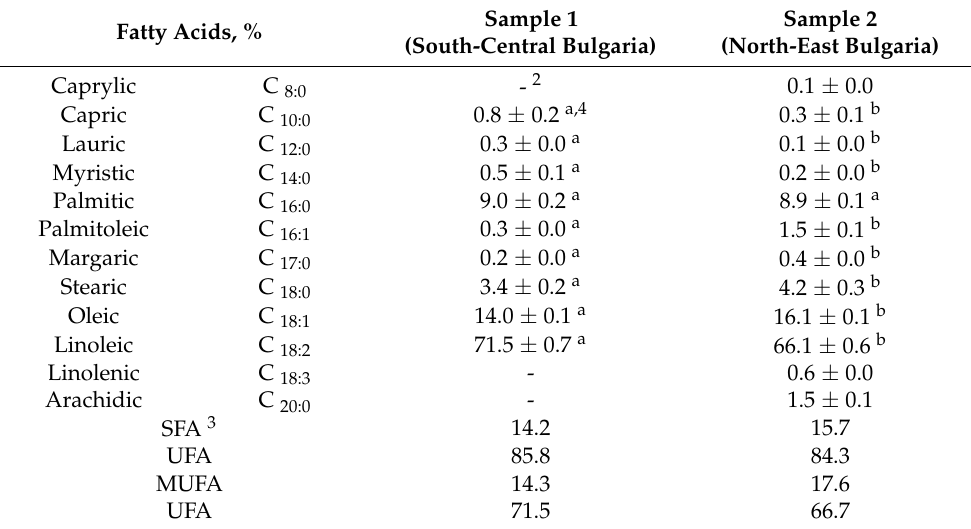
Table 5. Fatty acid composition of fruit vegetable oils 1